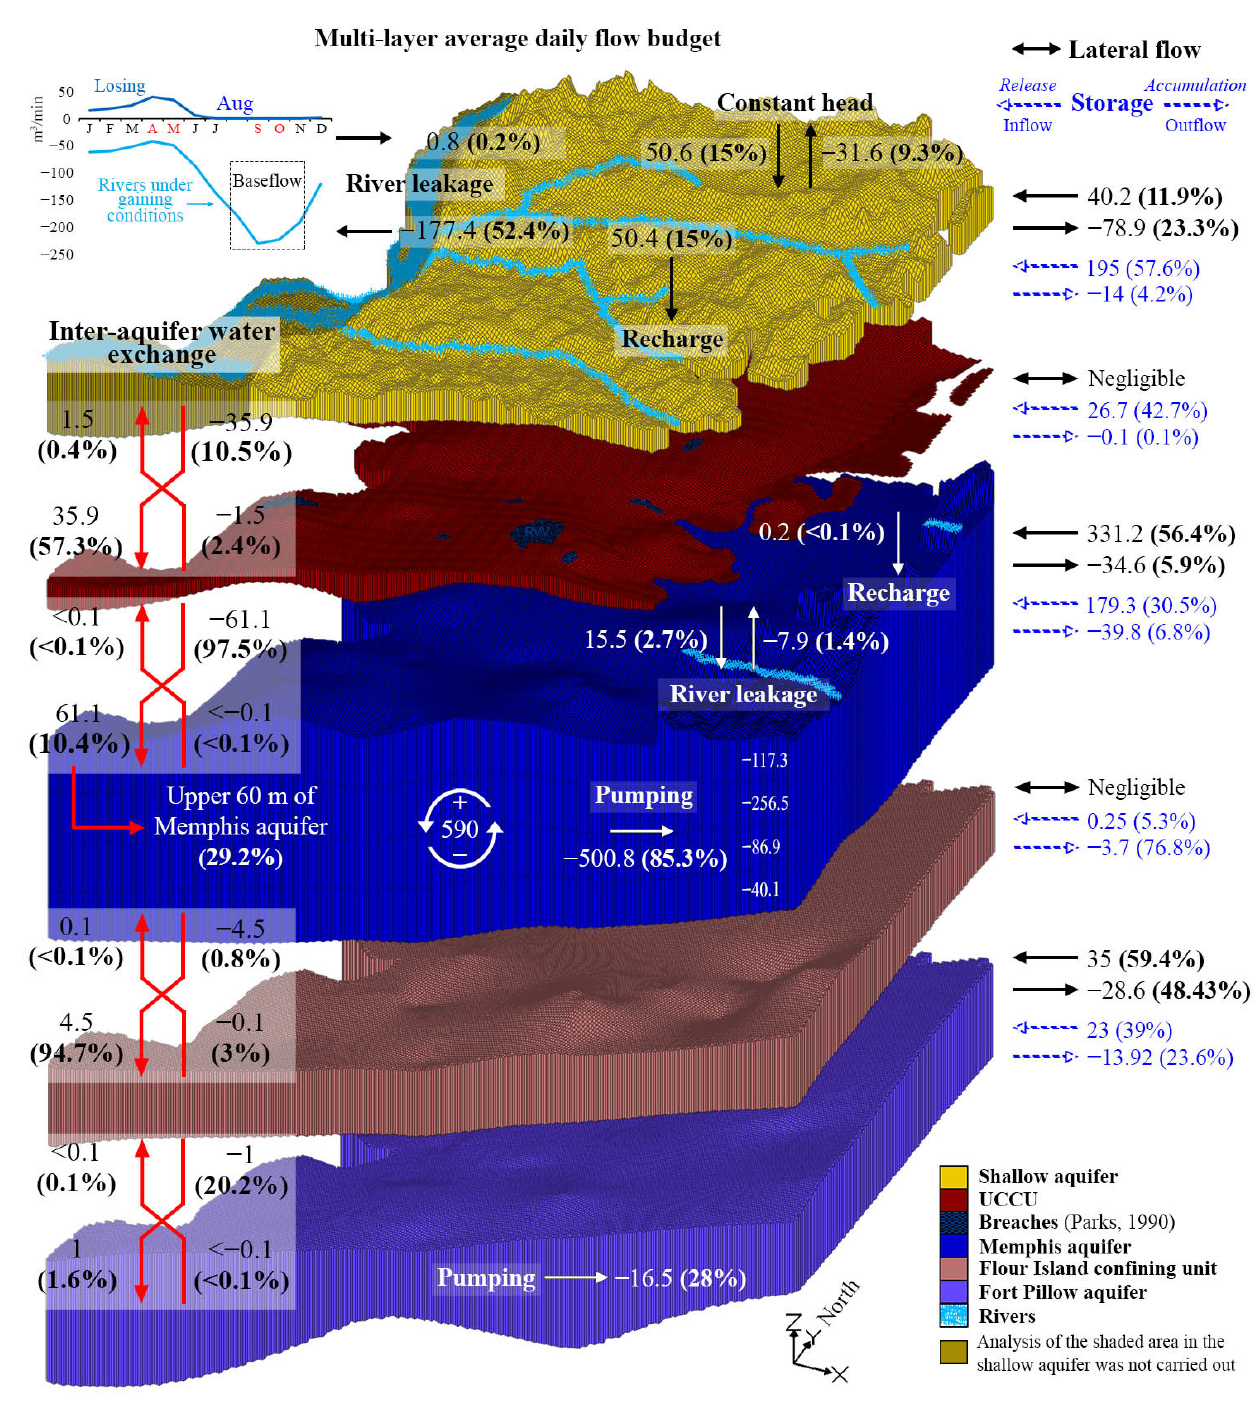
Figure 13. Multi-layer average daily flow budget for August 2016 in Shelby County. Average flows through the system are measured in m 3 /min and are also expressed as percentages of contribution to the total inflows (+) and outflows ( − ) of each hydrogeologic unit.